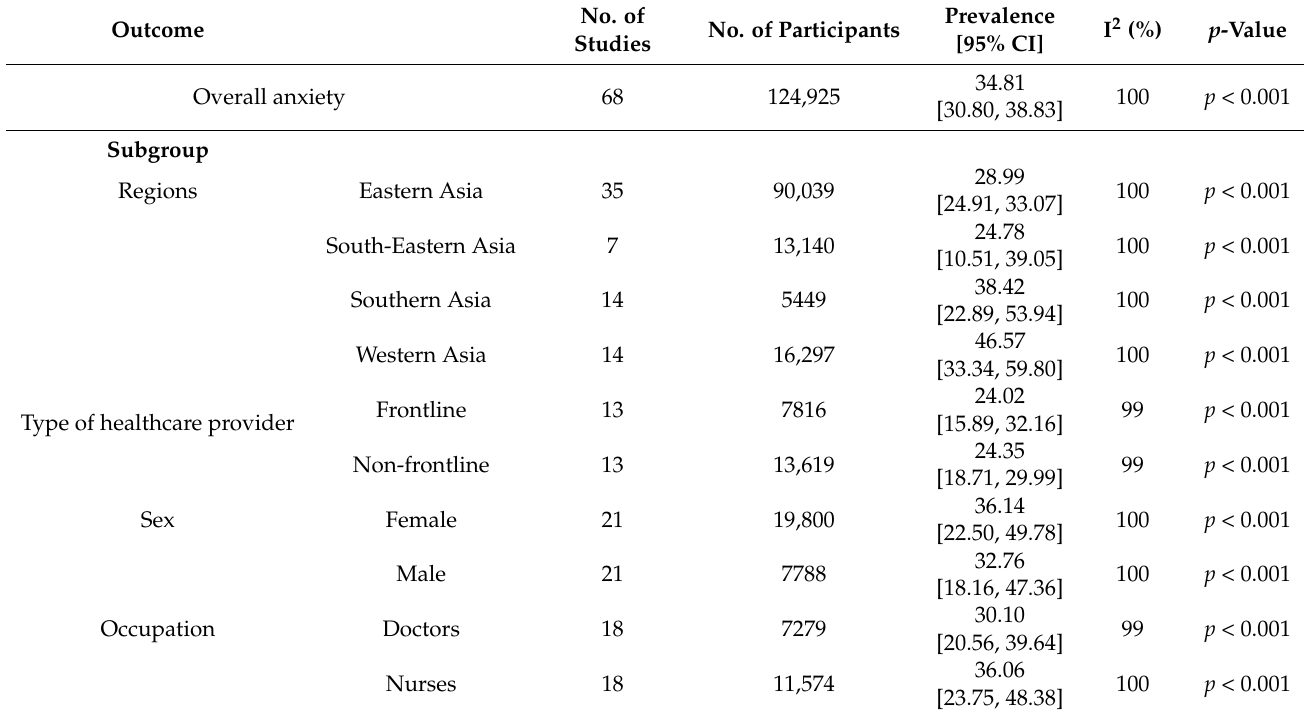
Table 1. Pooled prevalence of anxiety and its subgroup